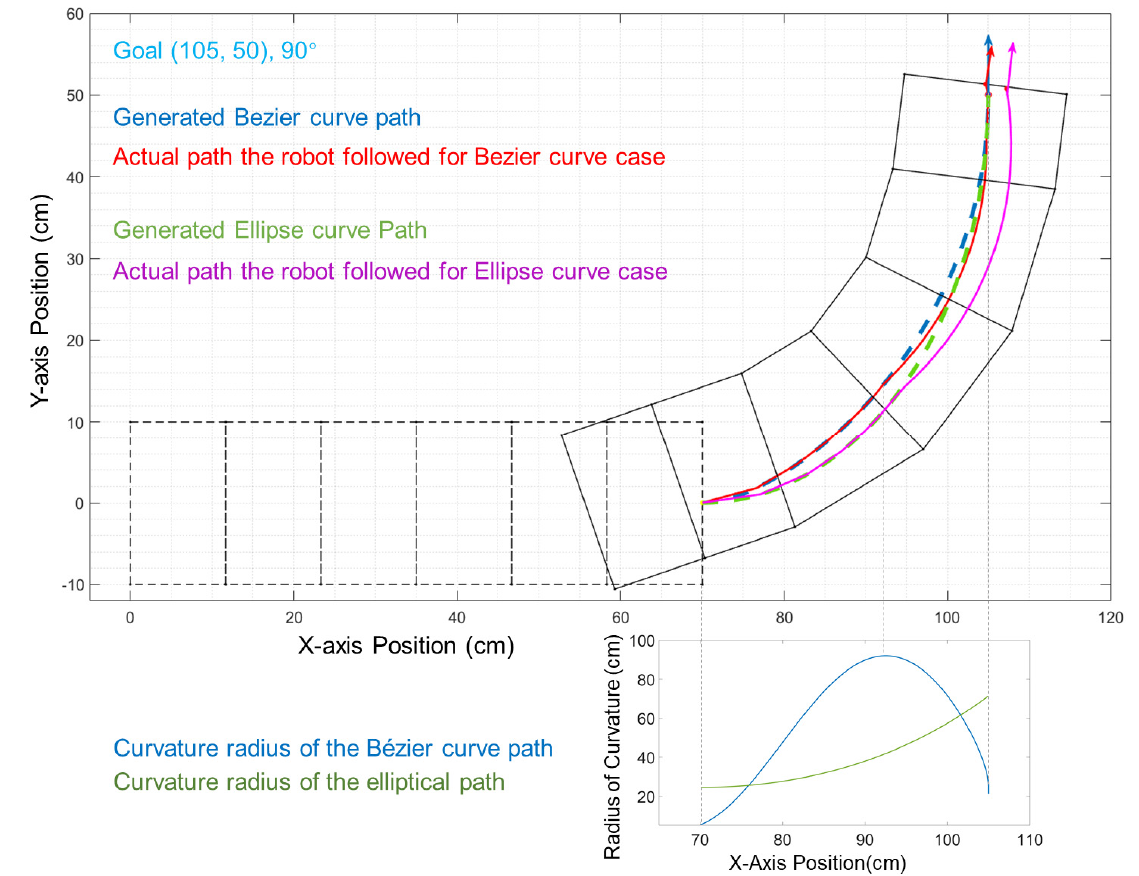
Figure 7. Comparisons between the elliptical path and the B é zier curve paths. The blue curve is the B é zier curve, and the pink is the executed path. The dotted green line is the previous elliptical path. The below figure shows the curvature radius of both paths.